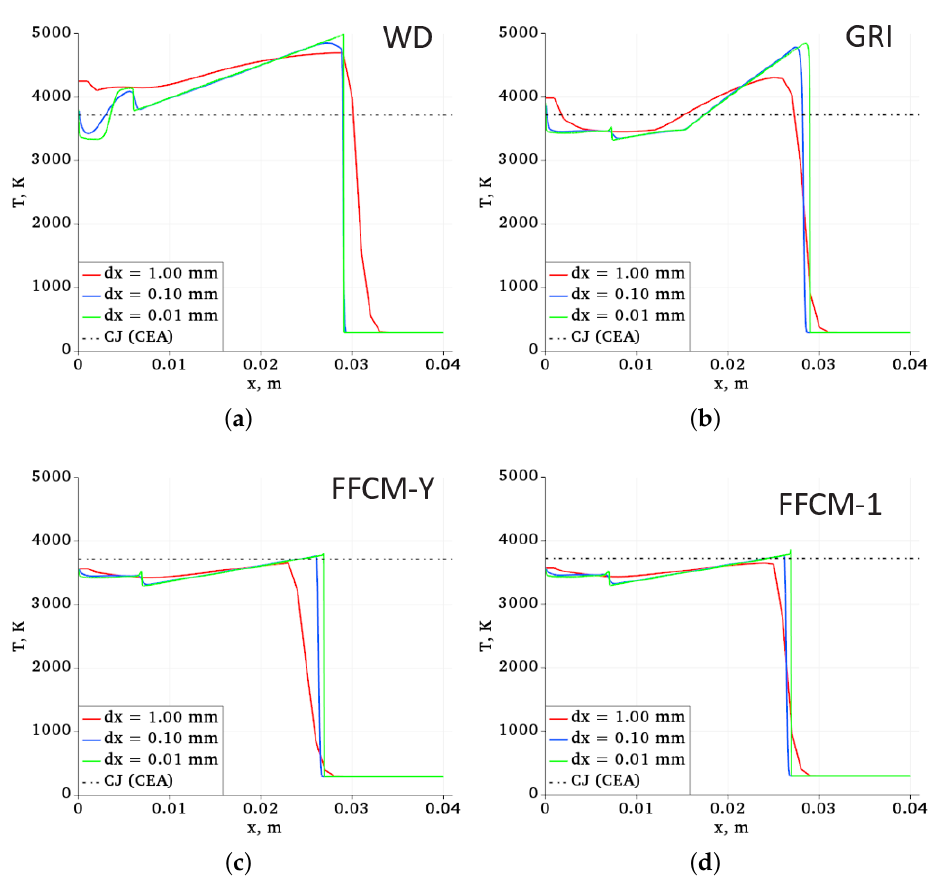
Figure 3. 1D detonation tube grid res. ( a ) WD, ( b ) GRI 3.0, ( c ) FFCMy-12, and ( d ) FFCM-1 [31]. A one-eighth RDRE sector grid and simulation with periodic boundary conditions at both azimuthal boundaries is provided for comparison. The sector grid is relatively coarser than the full RDRE, consisting of 10 million grid points. This grid would correlate to 80 million grid points for an entire RDRE annulus. The three chemical mechanisms used for the one-eighth sector simulation were are WD, FFCMy-12, and FFCM-1, and consumed 0.18 million, 0.28 million and 0.42 million CPU-hours